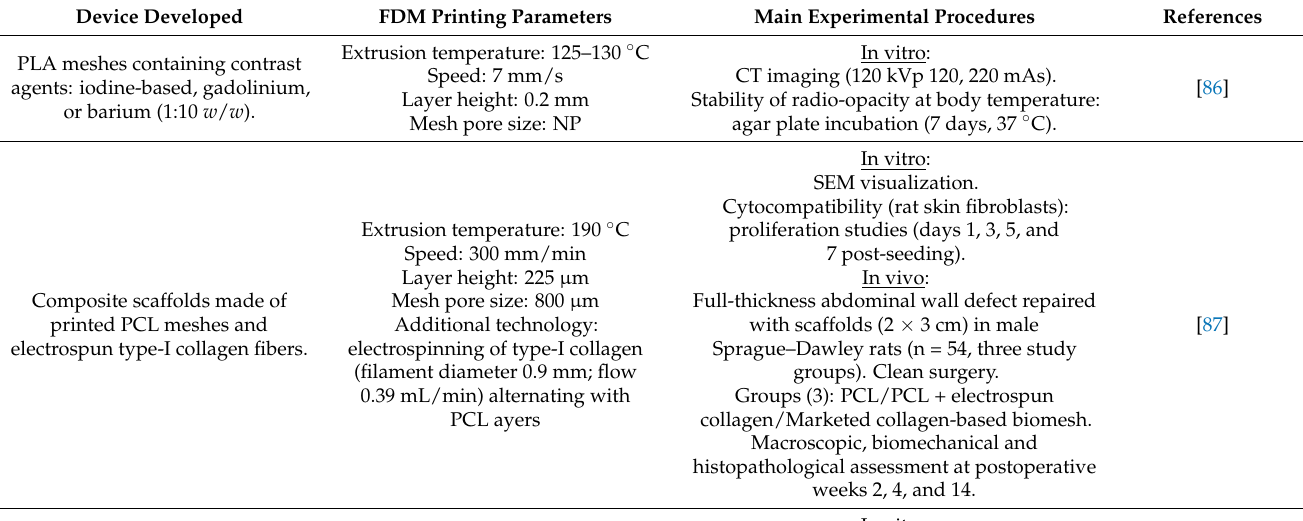
Table 1. Summary of the experimental research conducted to date to develop hernia repair mesh materials and scaffolds via additive-manufacturing technology. (Abbreviations: CT: computed tomography; FDM: fused deposition model; NP: not provided; PCL: polycaprolactone; PLA: polylactic acid; PP: polypropylene; PVA: polyvinyl alcohol; SEM: scanning electron microscopy).